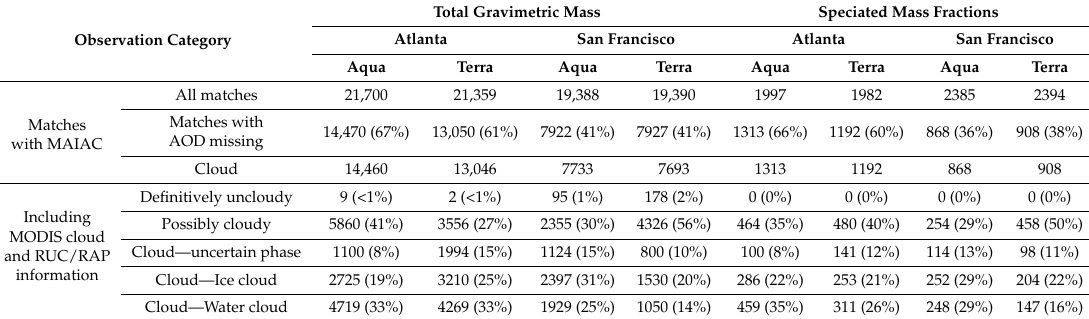
Table 2. Categorization of observations using Multi-Angle Implementation of Atmospheric Correction (MAIAC), then MODIS cloud and rapid update cycle (RUC)/RAPid refresh (RAP) information.